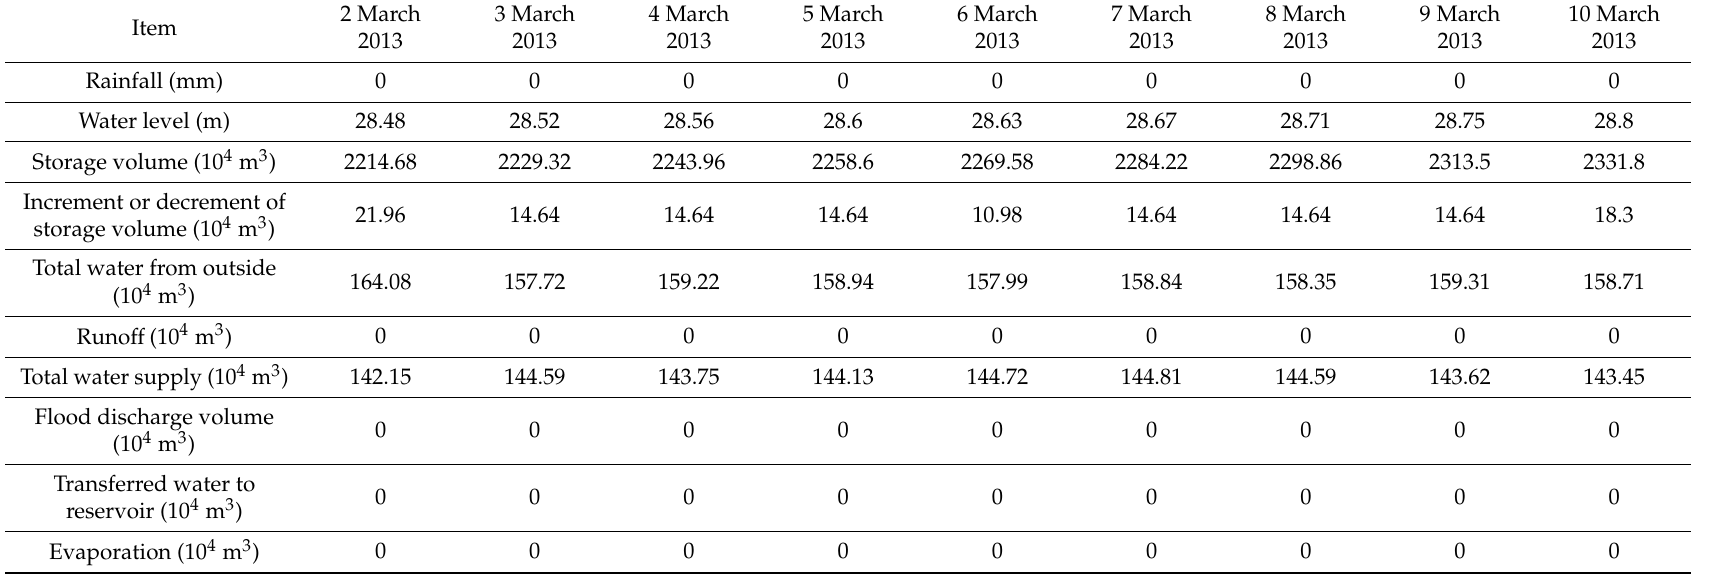
Table 5. The data results of the Xili reservoir during the dispatching